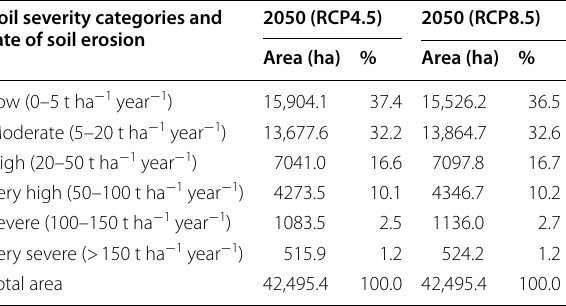
Table 10 Annual soil erosion risk classes and area coverage under RCP4.5 and RCP8.5 in Muga watershed Soil severity categories and rate of soil